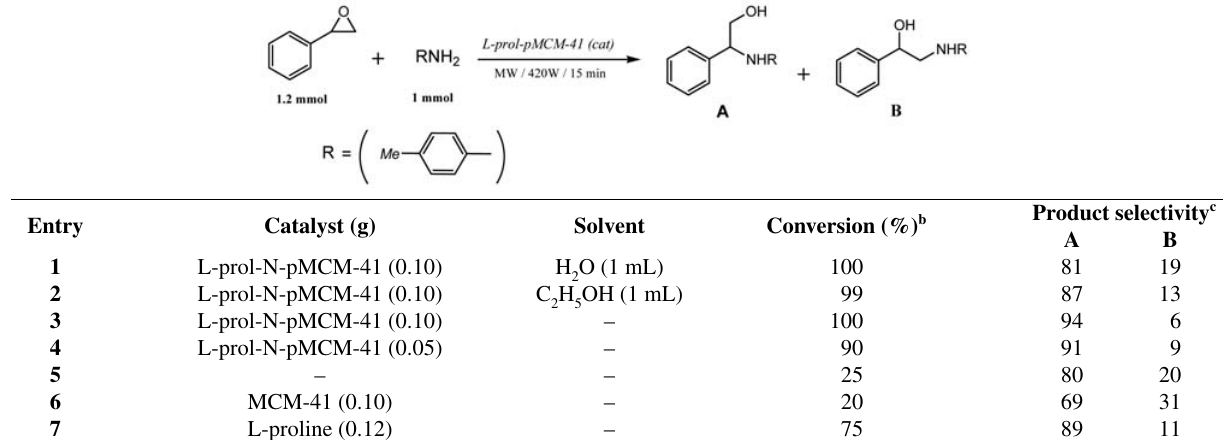
Table 2. Aminolysis of styrene oxide by 4-methylaniline ( 6 ) in the presence of L-prol-N-pMCM-41 as catalyst under microwave irradiation.